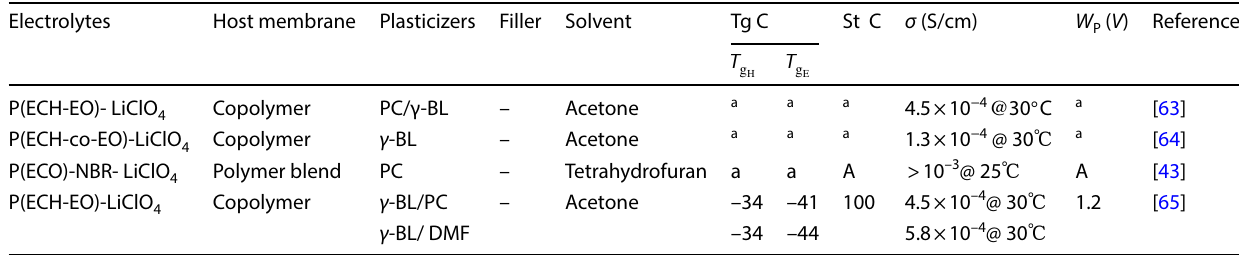
Table 3 Thermal properties, conductivities, and window potential of some plasticized (or gel) PECH-based